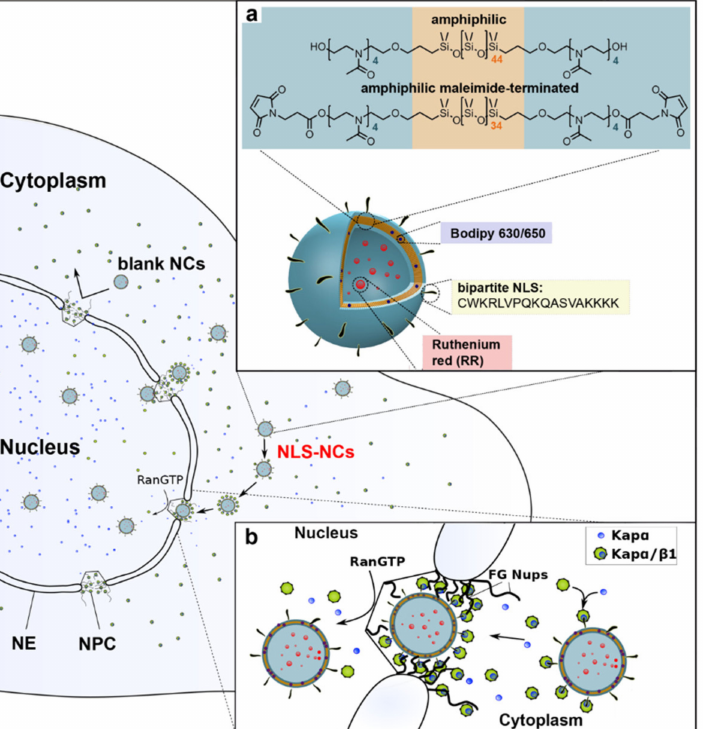
Figure 6. Organelle-specific targeting of polymersome NCs into the cell nucleus. ( a ) NLS-NCs self- assemble from amphiphilic PMOXA-PDMS-PMOXA triblock copolymers. Two model compounds are used to test for nuclear delivery: Ruthenium red (RR) that is encapsulated within the NLS-NC lumen, and Bodipy 630/650 that incorporates into its polymeric membrane. ( b ) The nuclear transport mechanism involves Kap α • Kap β 1 that (1) authenticates NLS-NCs for selective NPC transport, (2) binds to FG Nups, and (3) releases NLS-NCs into the nucleus upon binding RanGTP. Reprinted with permission from [213]. Copyright 2020 National Academy of